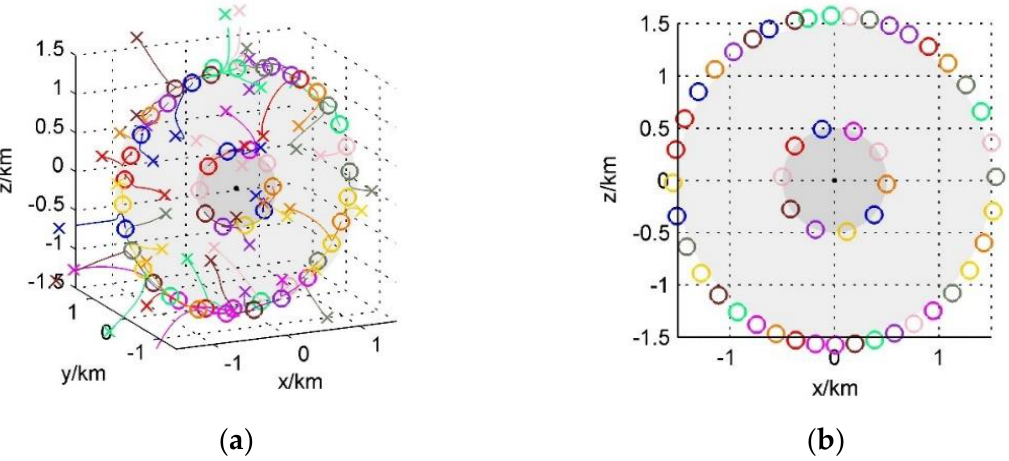
Figure 17. The in-plane concentric double circle formation ( r = 1 km, µ = 0.5 km). ( a ) Relative motion trajectory in 0–2000 s; ( b ) Distribution of satellite cluster at 2000 s.